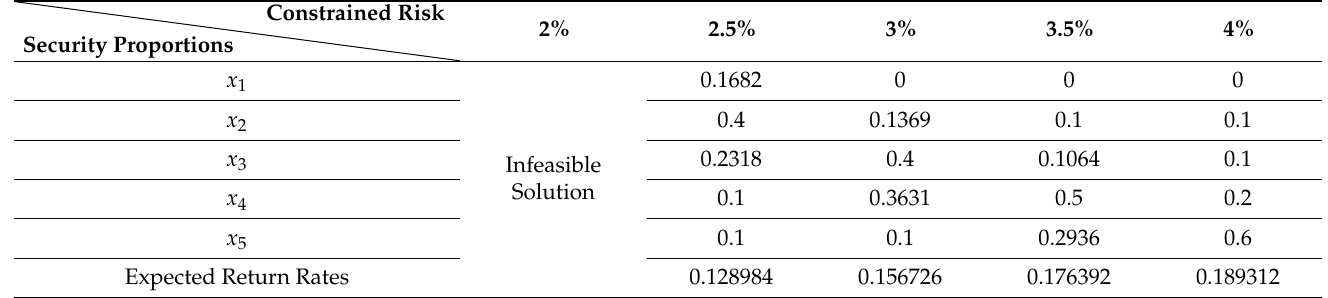
Table 16. The dimension with t = 3 and s = 5 with a guaranteed return rate (cid:101) p 1 in the proposed model.